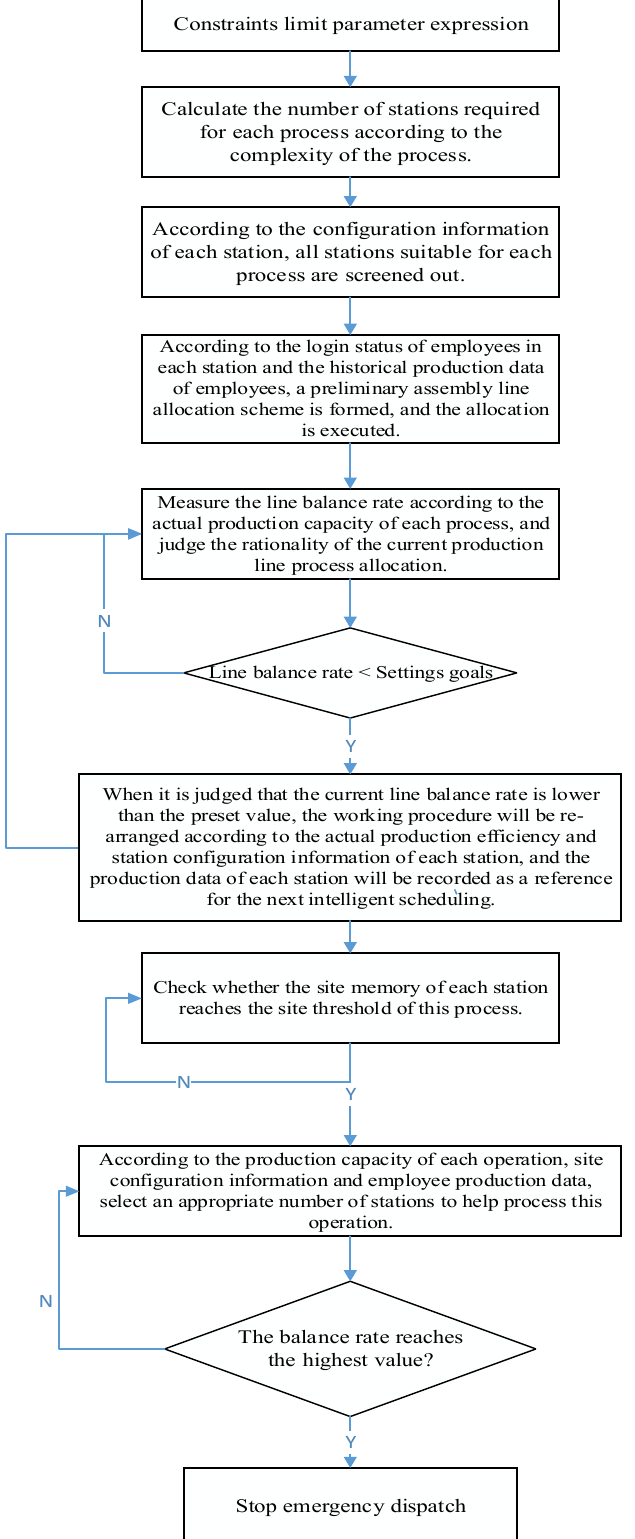
Figure 1. Multi-constraint intelligent production line scheduling process fl ow chart.